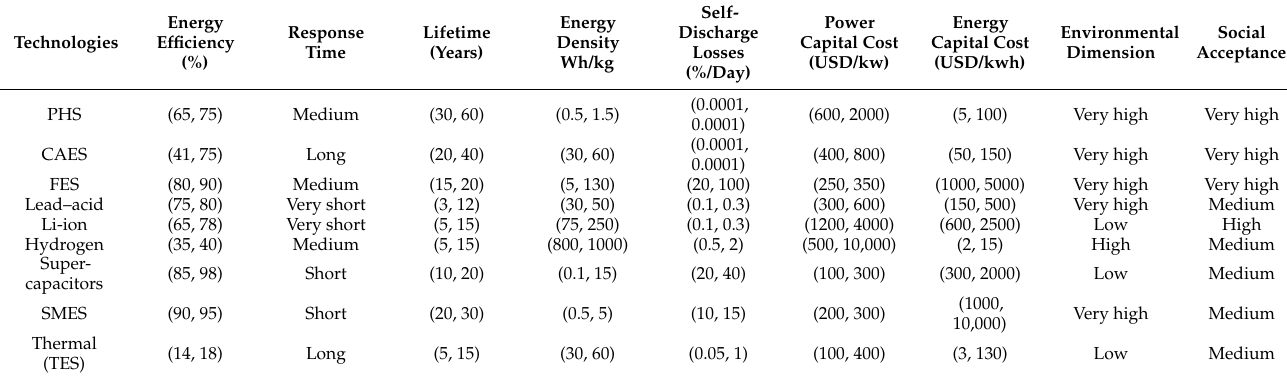
Table A13. Decision basic data of Expert